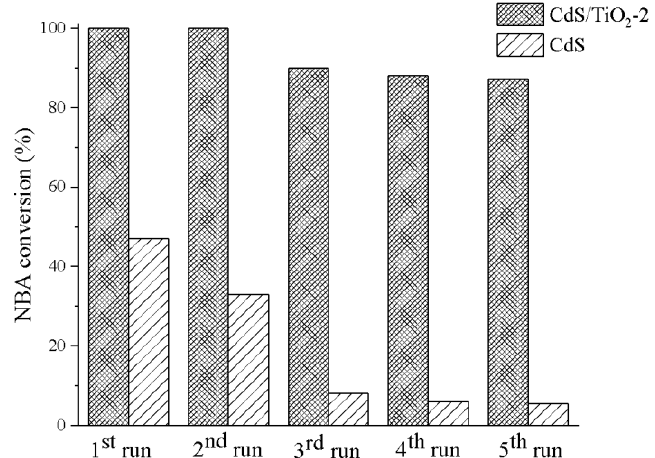
Figure 9. Conversion % of NBA during five repeated experiments obtained upon irradiation ( λ ≥ 420 nm, 30 min) of CdS/TiO 2 -2 or commercial CdS suspended in a deaerated CH 3 CN/2-PrOH (4/1) reaction mixture containing a starting NBA concentration of 1 × 10 −4 M.